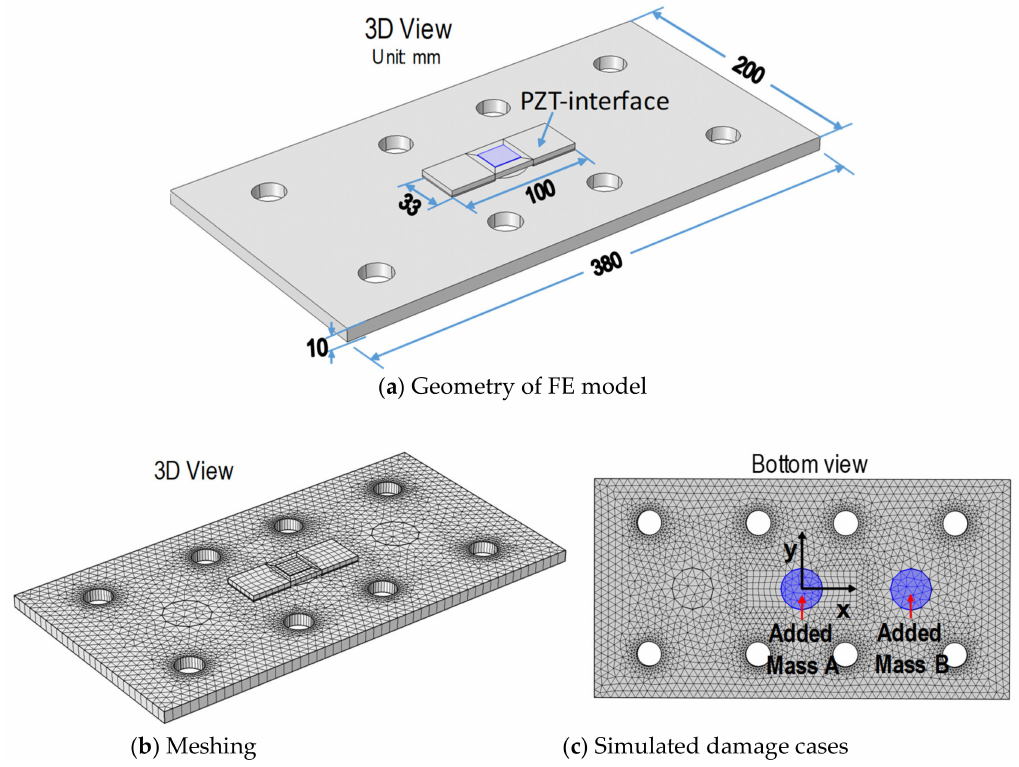
Figure 15. FE modeling for analyzing sensing region of PZT interface on a connection splice